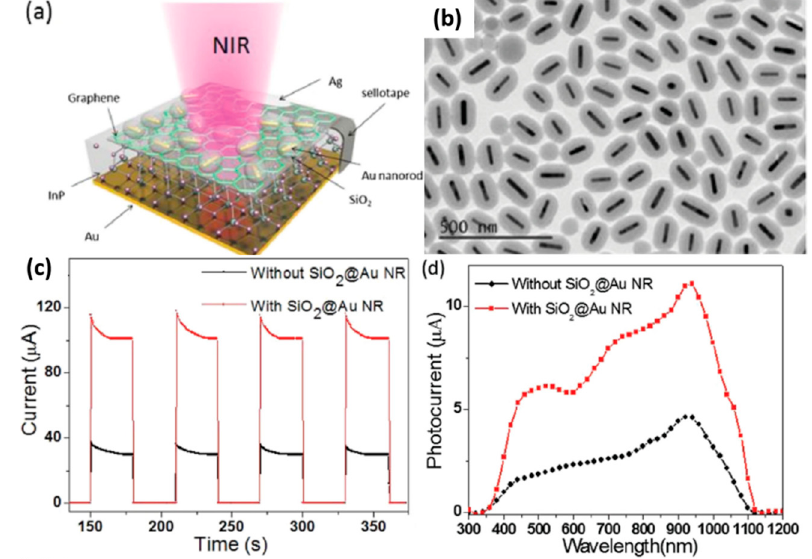
Figure 5. ( a ) The schematic diagram of the SiO 2 @AuNRs-SLG/InP PD device. ( b ) The TEM image of the SiO 2 @AuNRs on single layer graphene film. ( c ) Photoresponse of two different devices with and without SiO 2 @AuNRs modification under 980 nm light illumination of 6.7 mW cm − 2 without applied bias. ( d ) Photoresponsivity of the NIR PDs with and without SiO 2 @Au decoration [96].